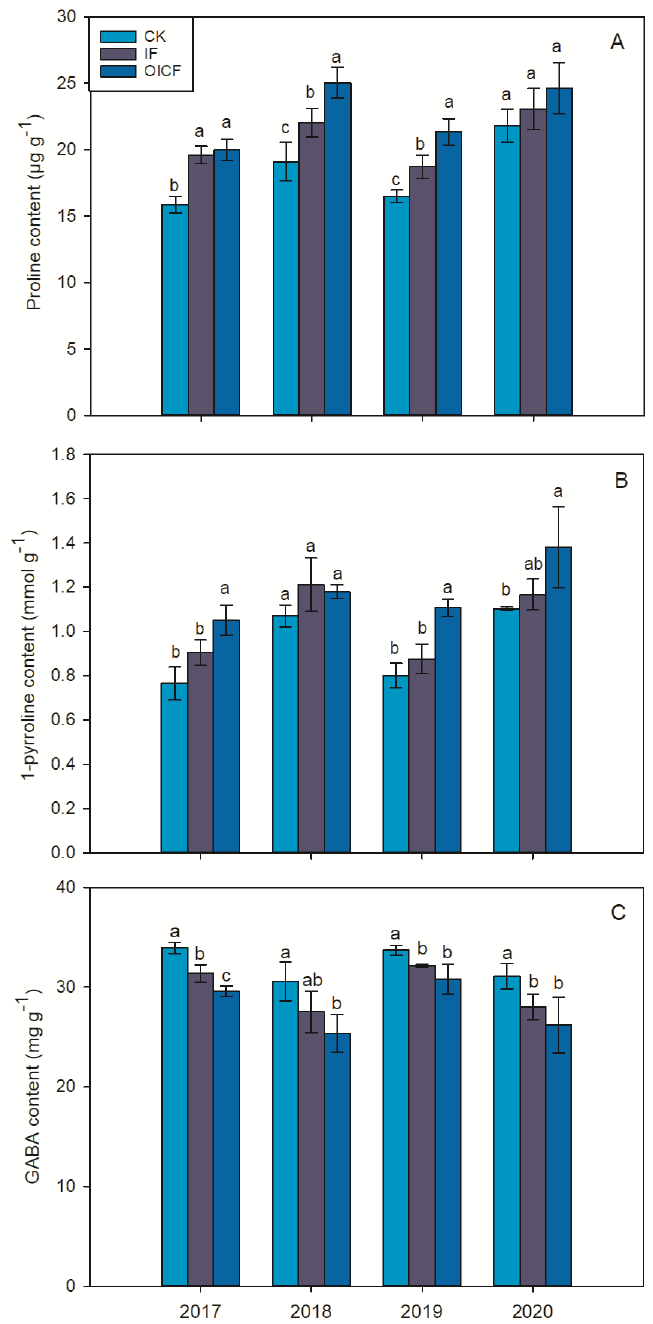
Figure 5. Effects of new organic-inorganic compound fertilizer on the content of proline ( A ), 1-pyrroline ( B ), GABA ( C ) in fragrant rice. Bars sharing a common letter do not differ significantly at p ≤ 0.05.